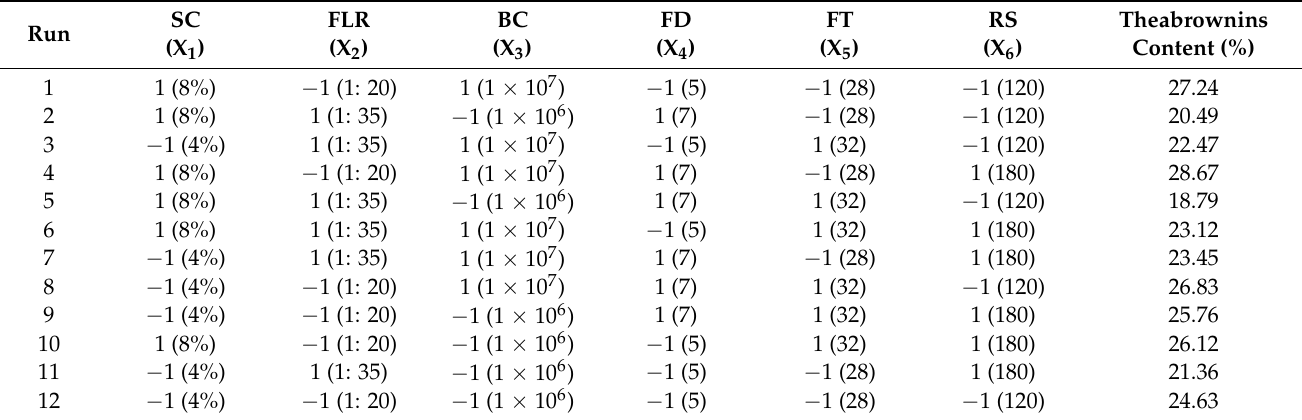
Table 3. Plackett–Burman experimental design and response values.